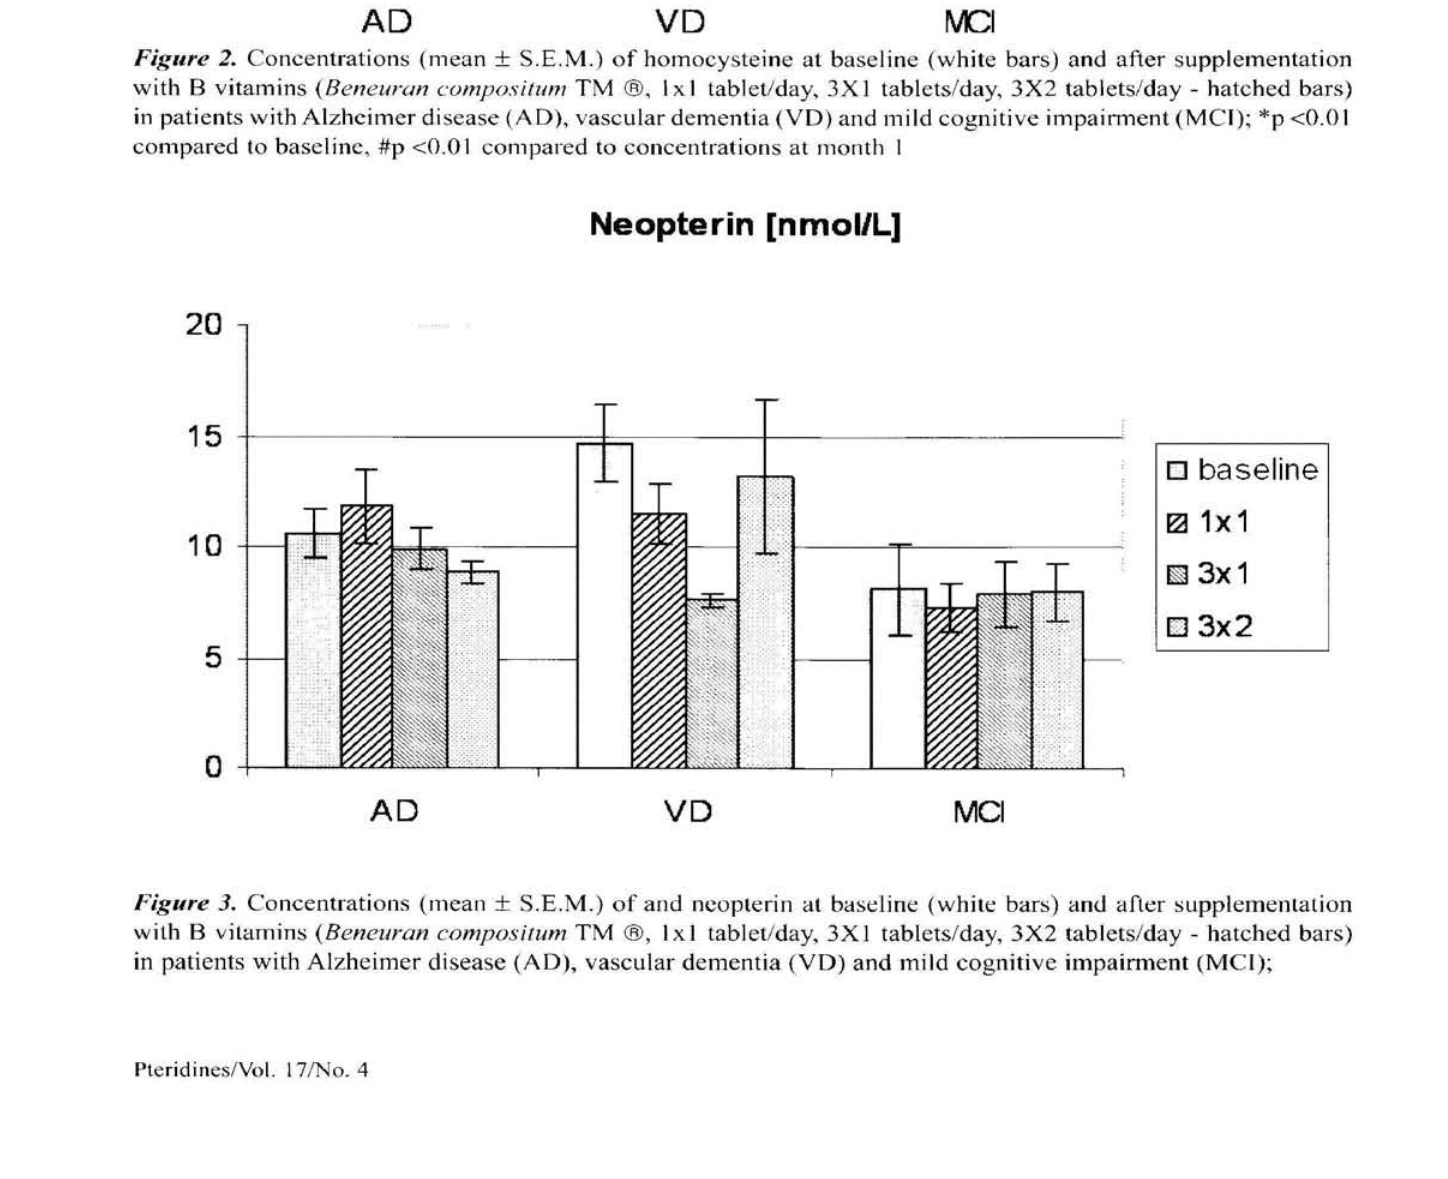
Pteridines/Vol. 17/No.